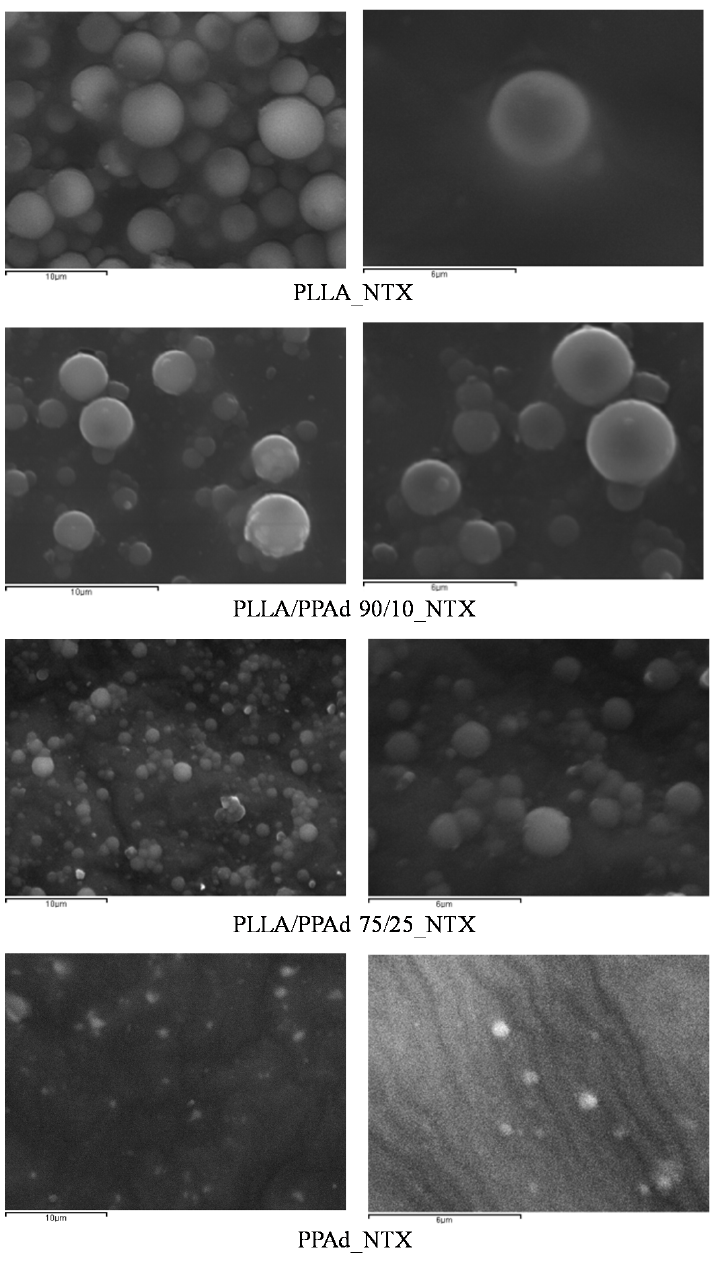
Figure 10. SEM micrographs of prepared microparticles loaded with naltrexone base (NTX). Table 4. Characteristics of prepared naltrexone-loaded microparticles such as yield of